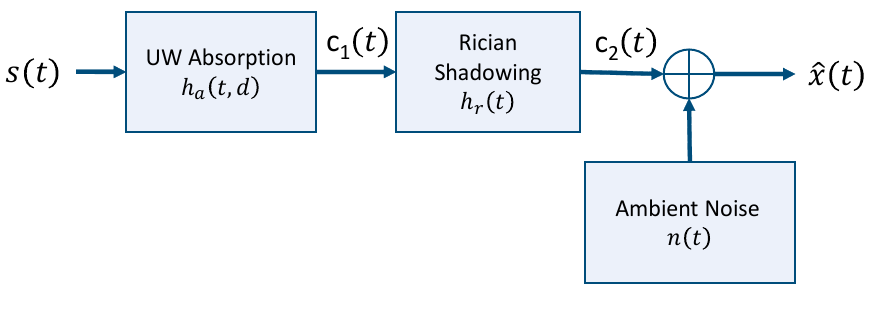
Figure 3. UWA channel model [45,52].